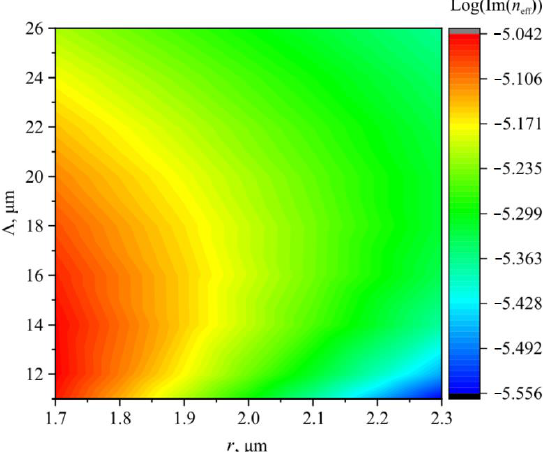
Figure 5. Dependence of waveguide losses of the fundamental core mode of an HF with one row of the cladding holes on values of the cladding hole radius and pitch; the refractive index of the glass matrix is 1.45. The calculation was carried out at a wavelength of 1 µm for circular polarization. Cross-section of the fiber is shown in Figure 3.